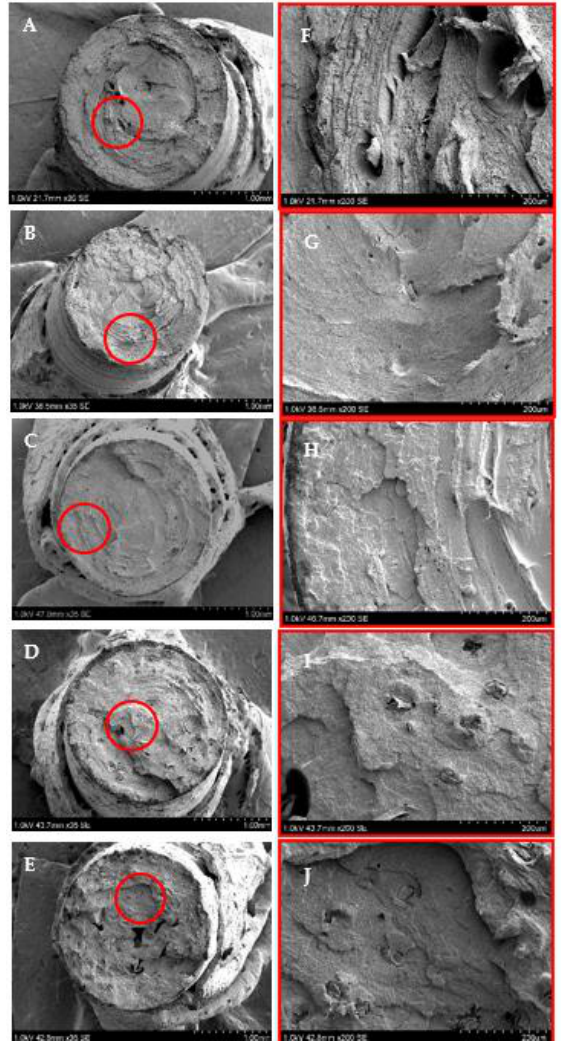
Figure 5. SEM micrographs of tensile tested fused filaments fractured surfaces: ( A ) denotes PHB (55%)/PLA (45%); ( B ) denotes PHB (55%)/PLA (45%) + 2 wt.% CC; ( C ) denotes PHB (55%)/PLA (45%) + 4 wt.% CC; ( D ) denotes PHB (55%)/PLA (45%) + 6 wt. % CC; ( E ) denotes PHB (55%)/PLA (45%) + 8 wt.% CC. Micrographs ( E – J ) are magnified images of the regions denoted by circles in micrographs A to E, respectively.